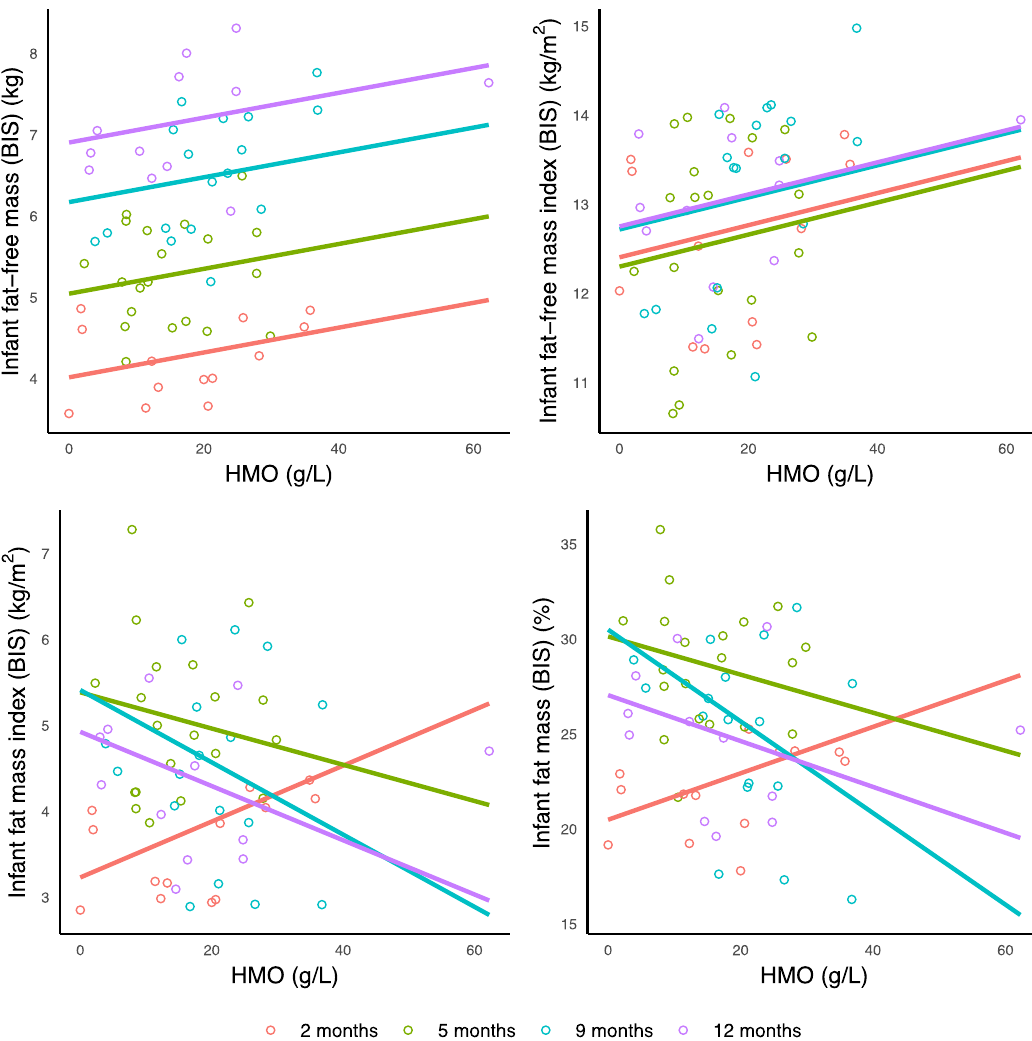
Figure 2. Significant associations between concentration of human milk oligosaccharides (HMO) and infant body composition parameters measured with bioelectrical impedance spectroscopy (BIS). Lines represent linear regression and grouped by the month of lactation.